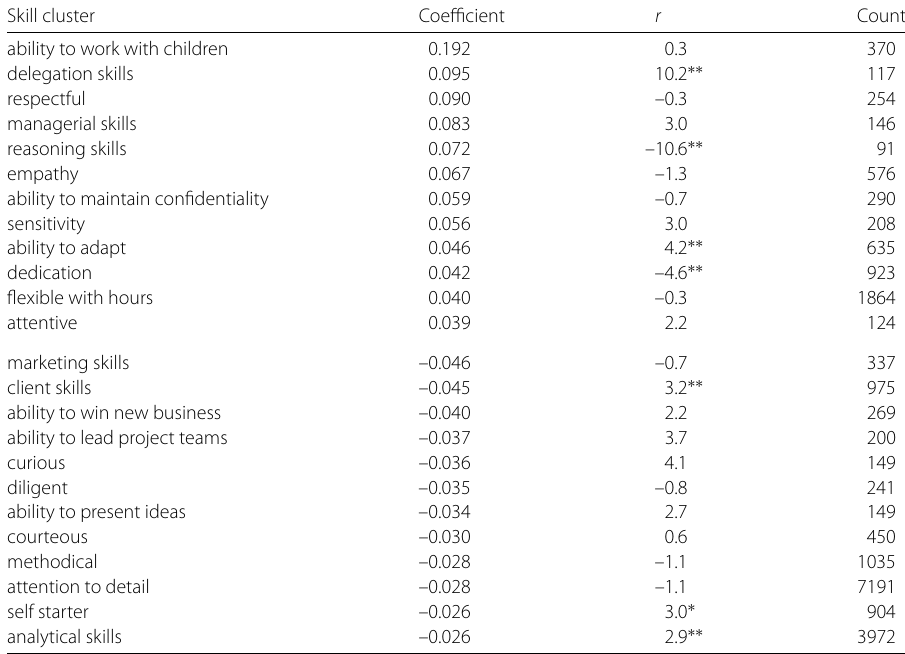
Table 4 OLS regression results predicting the proportion of women using soft skill clusters as predictors Skill cluster Coefficient r Count ability to work with children